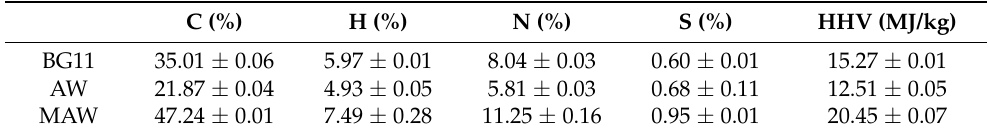
Figure 4. ( a ) TG and, ( b ) DTG analysis of pyrolysis process. Table 1. Elemental analyses and the higher heating values (HHV) of microalgae biomass cultivated in BG11, AW and MAW